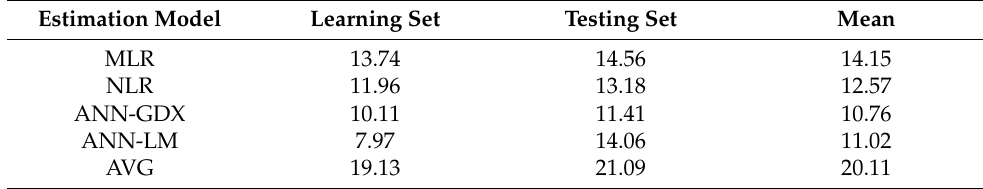
Table 3. The results of experiments (in